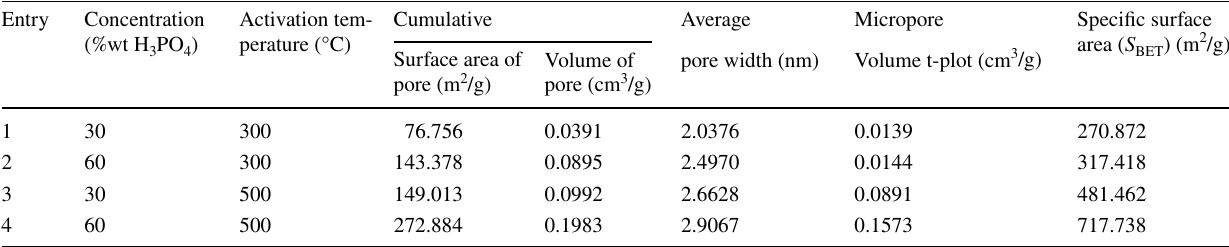
Table 3 Surface properties of the activated carbons from hazelnut shell